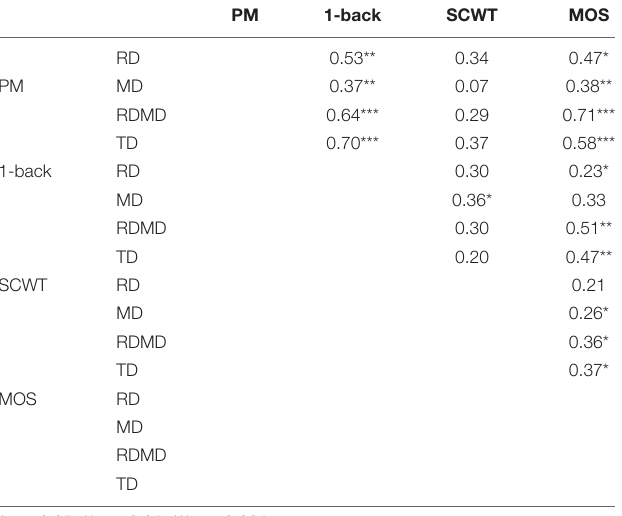
TABLE 5 | Differences between typically developing (TD) group and the other three groups on the response time of prospective memory after controlling for executive